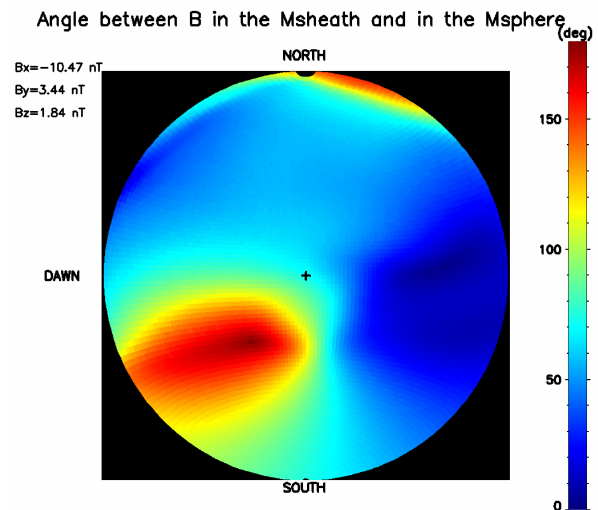
Fig. 12. Colour map of the shear angle along the magnetopause dur- ing the far-off crossing of a fully south MC when its axis is located at x = 1000 R E upstream of Earth. See the caption of Fig. 9 for de- tails.